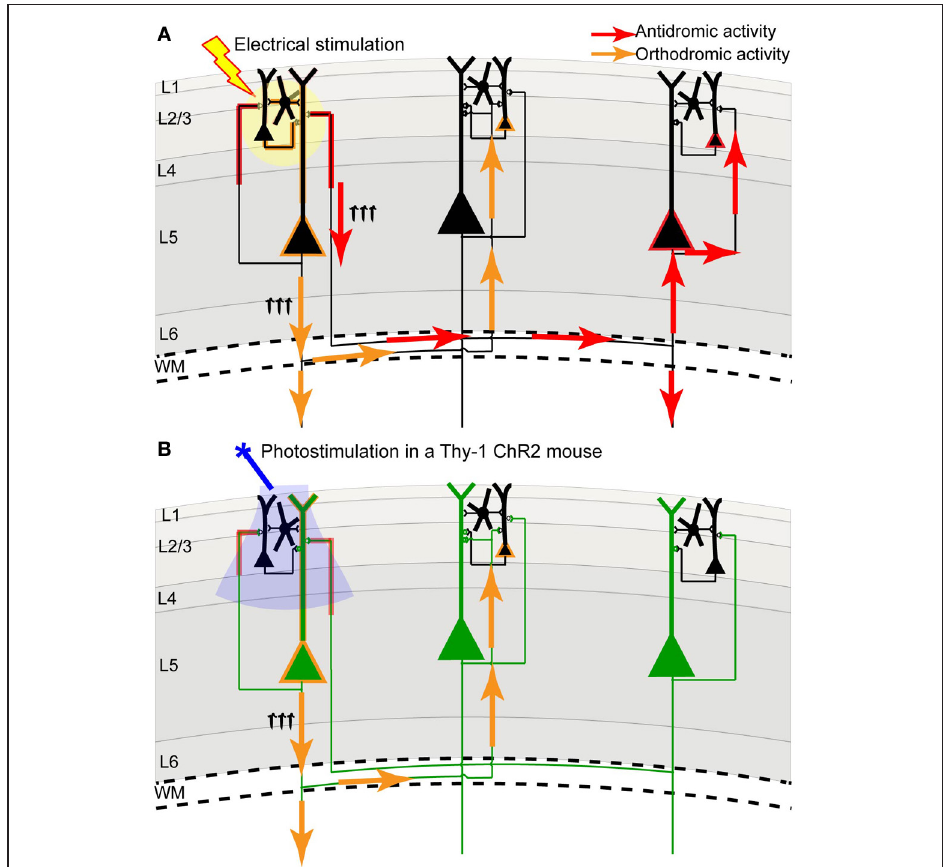
FIGURE 2 | Channelrhodopsin-2 stimulation in the Thy-1 transgenic mouse may result in more specific activation compared to direct electrical stimulation. (A) In direct electrical stimulation all cellular components and all cell types within the area of electrical stimulation (indicated by the yellow circle) are activated, inducing both antidromic (axon to soma/dendrite; red arrows) and orthodromic (dendrite/soma to axon; orange arrows) activation. Because electrical stimulation can activate axons (including axons of passage), it may reveal the source of a projection and not its target. (B) In photostimulation of the Thy-1 line 18 transgenic mouse (Arenkiel et al., 2007), predominantly layer 5 ChR2-expressing neurons (indicated in green) are directly activated. While ChR2 is expressed in both axons and dendrites, we suggest that the tuft dendrites of layer 5 neurons are more prominent near the brain surface (where light stimulation is directed) and more likely to become activated, inducing primarily orthodromic synaptic stimulation of distant targets (as determined by antagonist sensitivity; Lim et al.,